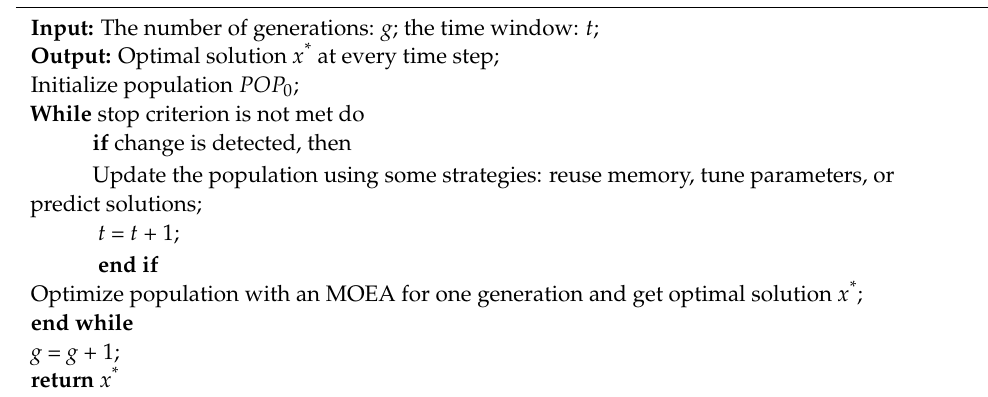
Algorithm 1: The main frame of